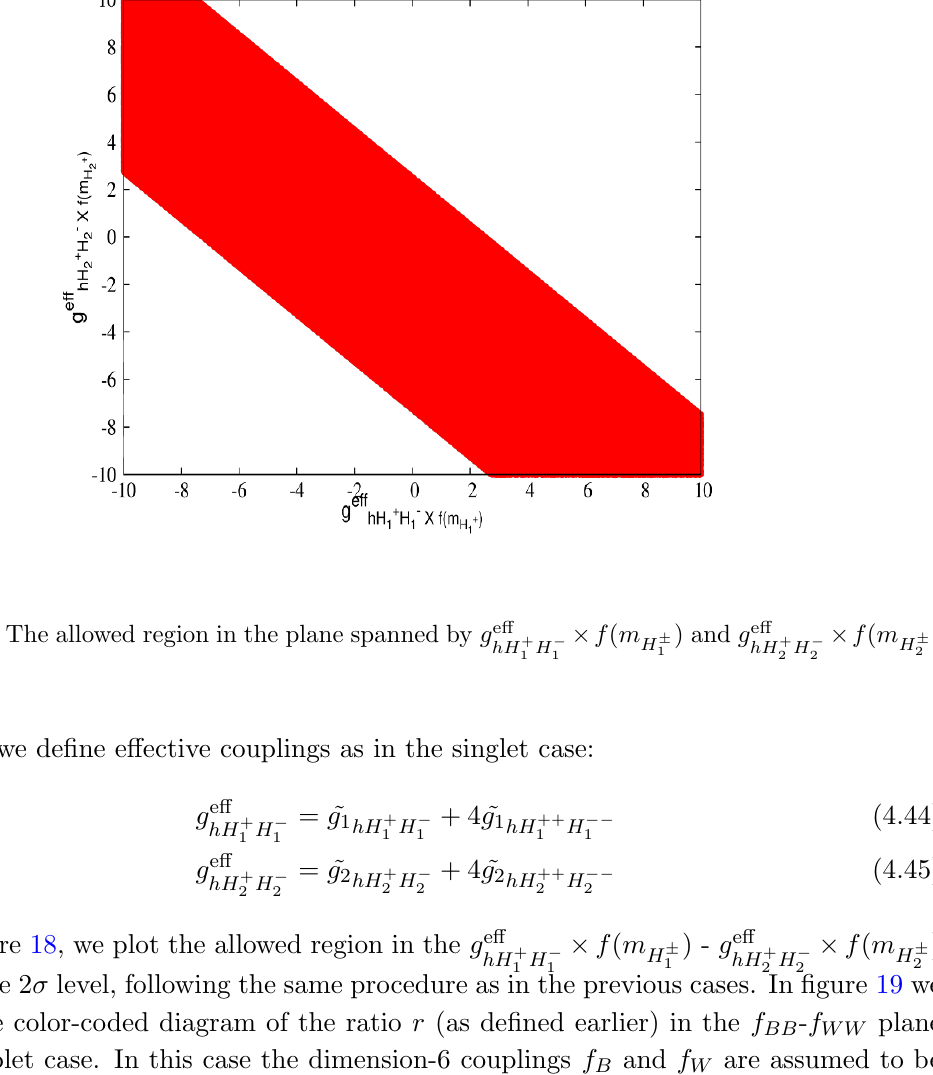
Figure 18 . The allowed region in the plane spanned by g e(cid:11) at 2 (cid:27)